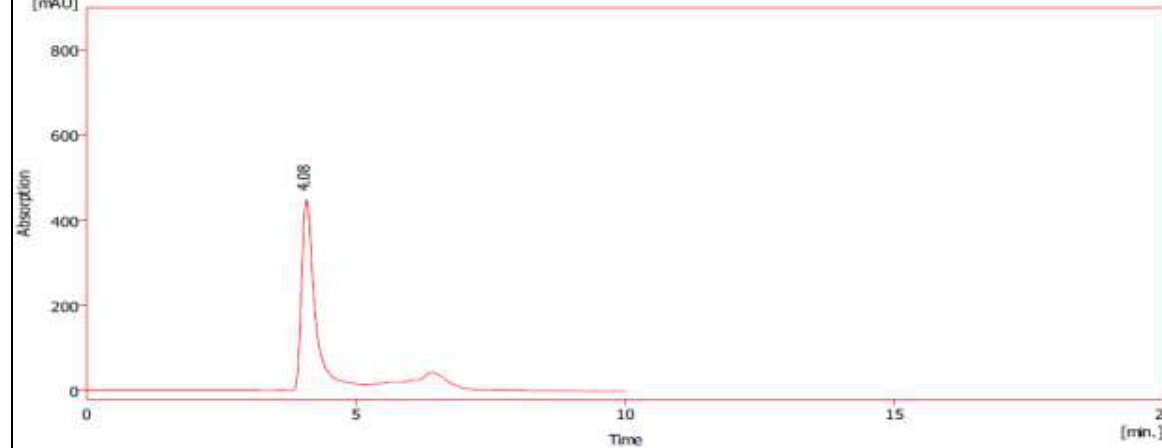
Figure 7. HPLC chromatogram for epicatechin standard